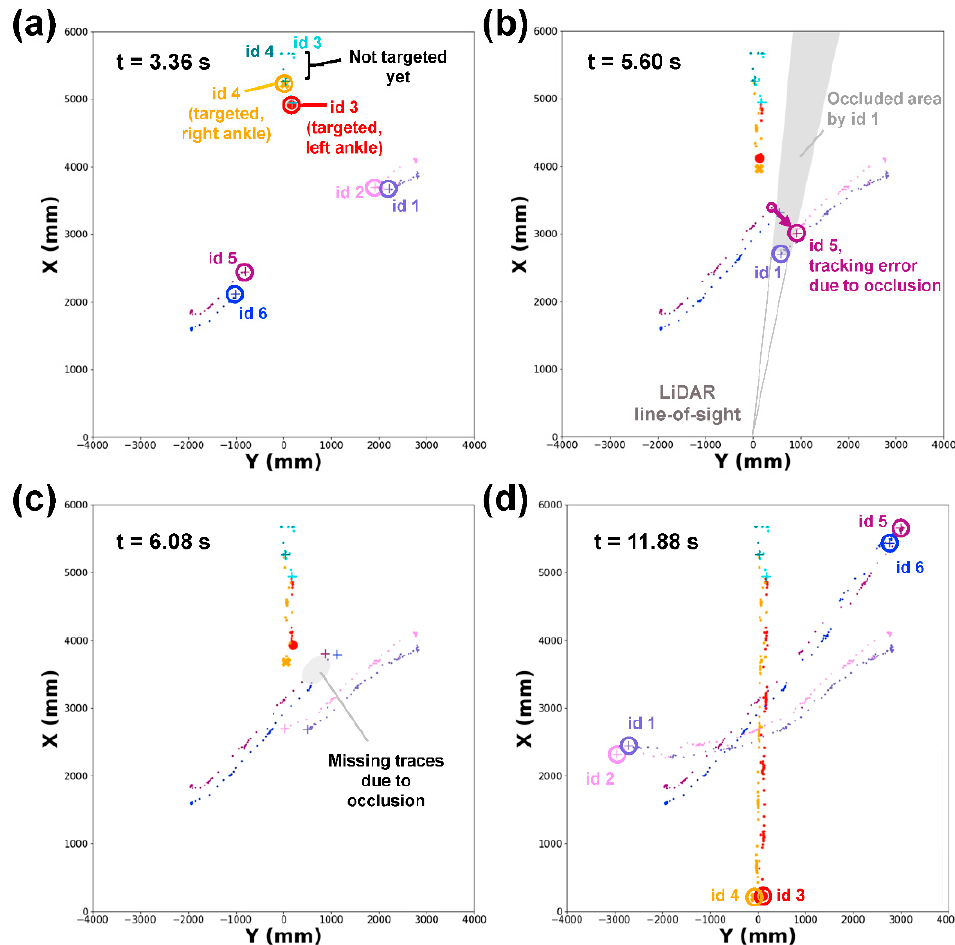
Figure 6. Tracking test for multiple targets via 2D-LiDAR with IOTA. ( a – d ) Tracked object snapshots for various time frames with the initial detection of the target ankles ( a ), the occurrence of occlusion ( b ), the restoration of tracking from the occlusion ( c ), and the end of measurement ( d ). A total of three people (i.e., six feet) with the targeted left (ID 3) and right (ID 4) ankles, and untargeted ankles (ID 1, 2, 5, and 6) are presented.